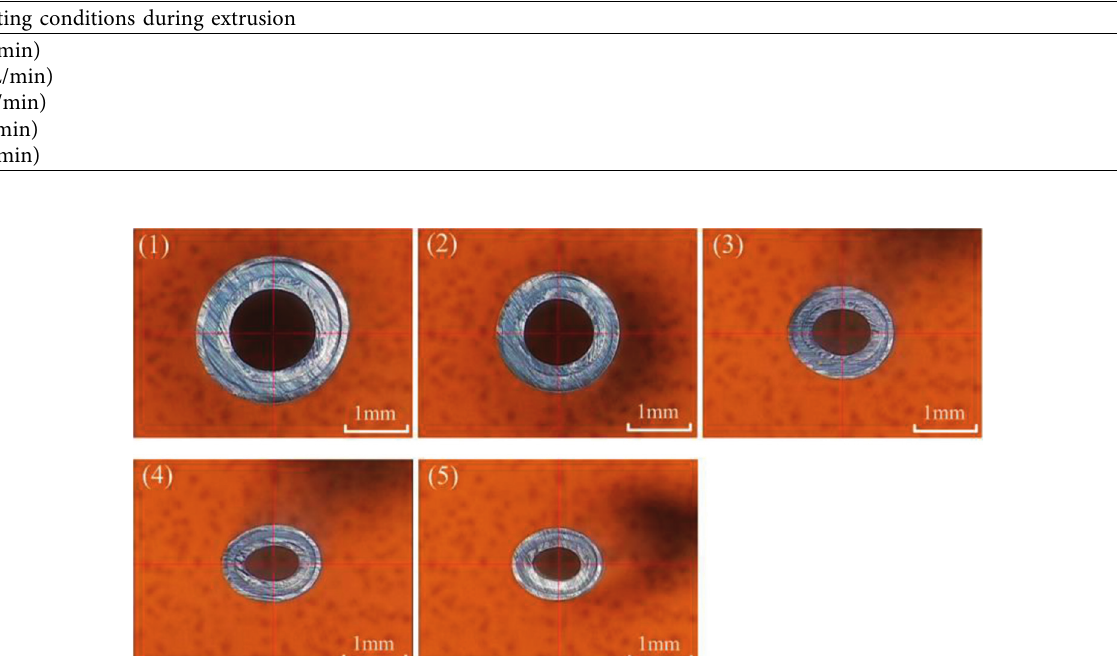
Figure 5: Graphics of cross sections of catheters at different pulling speeds. (a) V V 4 � 10m/min, and (5) V 5 �